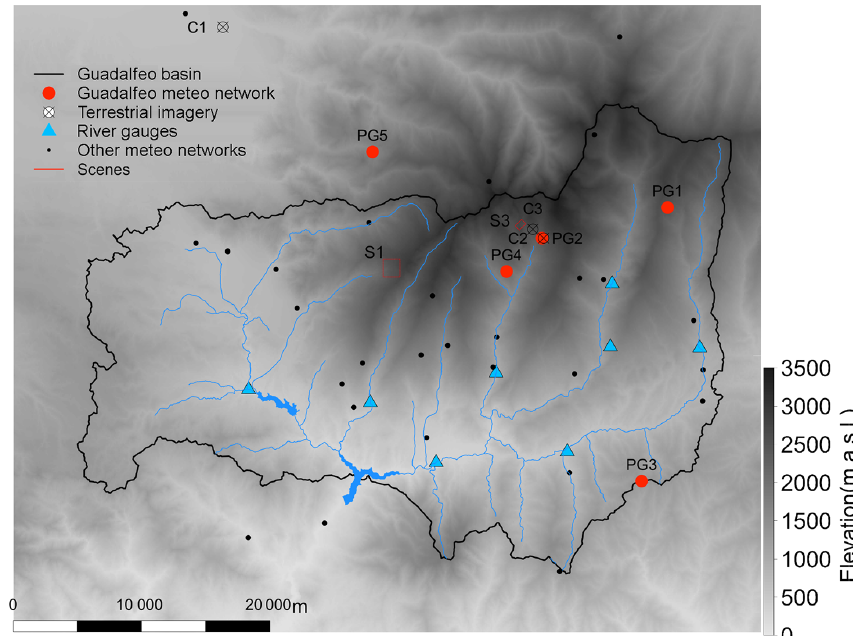
Figure 2. The Guadalfeo Network in Sierra Nevada (Spain). PG, weather stations (red circles); C, time-lapse cameras (crossed circles); S, the camera scenes (red rectangles; S2 is a near-field scene and cannot be represented due to its size). Black points identify the location of weather stations belonging to other meteorological networks in the Sierra Nevada area. The limits of the Guadalfeo Experimental Catchment (black line), the main river streams (blue line), gauge stations (blue triangles) and reservoirs (blue areas) are included over the elevation map of the area.